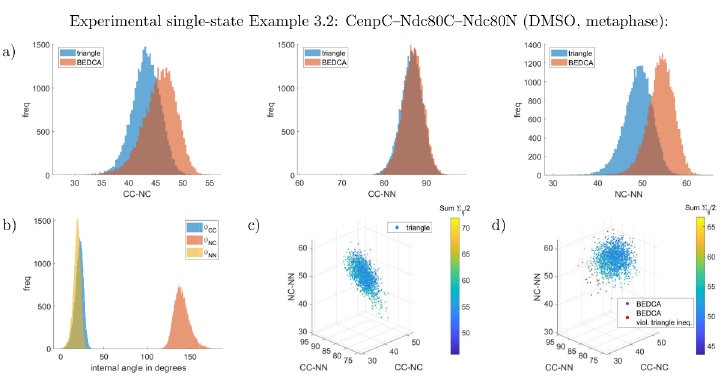
Fig 6. Marginal posteriors of the CenpC–Ndc80C–Ndc80N experiment in DMSO treatment (Example 3.2). Panels are the same as in Fig 3. All lengths are given in nm and have flat priors. See supplement Uninformative priors in S1 Text for the joint priors. Constructing a joint distribution from the three pair-wisely inferred lengths assuming independence yields 1% violations of the triangle inequality (red dots in panel d)).